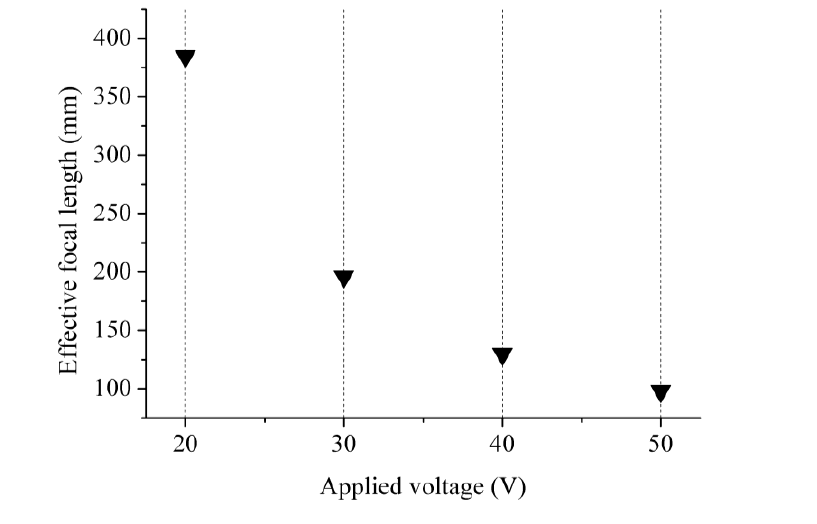
Figure 8. The focal length of the purposed LC lens with applied voltages, 20 V, 30 V, 40 V and 50